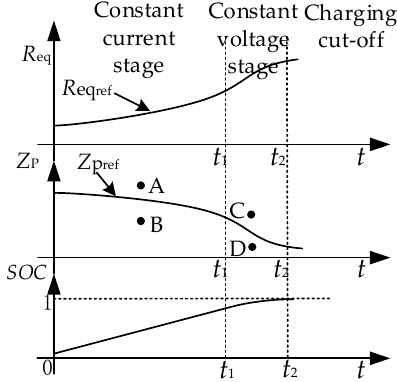
Figure 7. The diagram of both side impedance and SOC of battery.